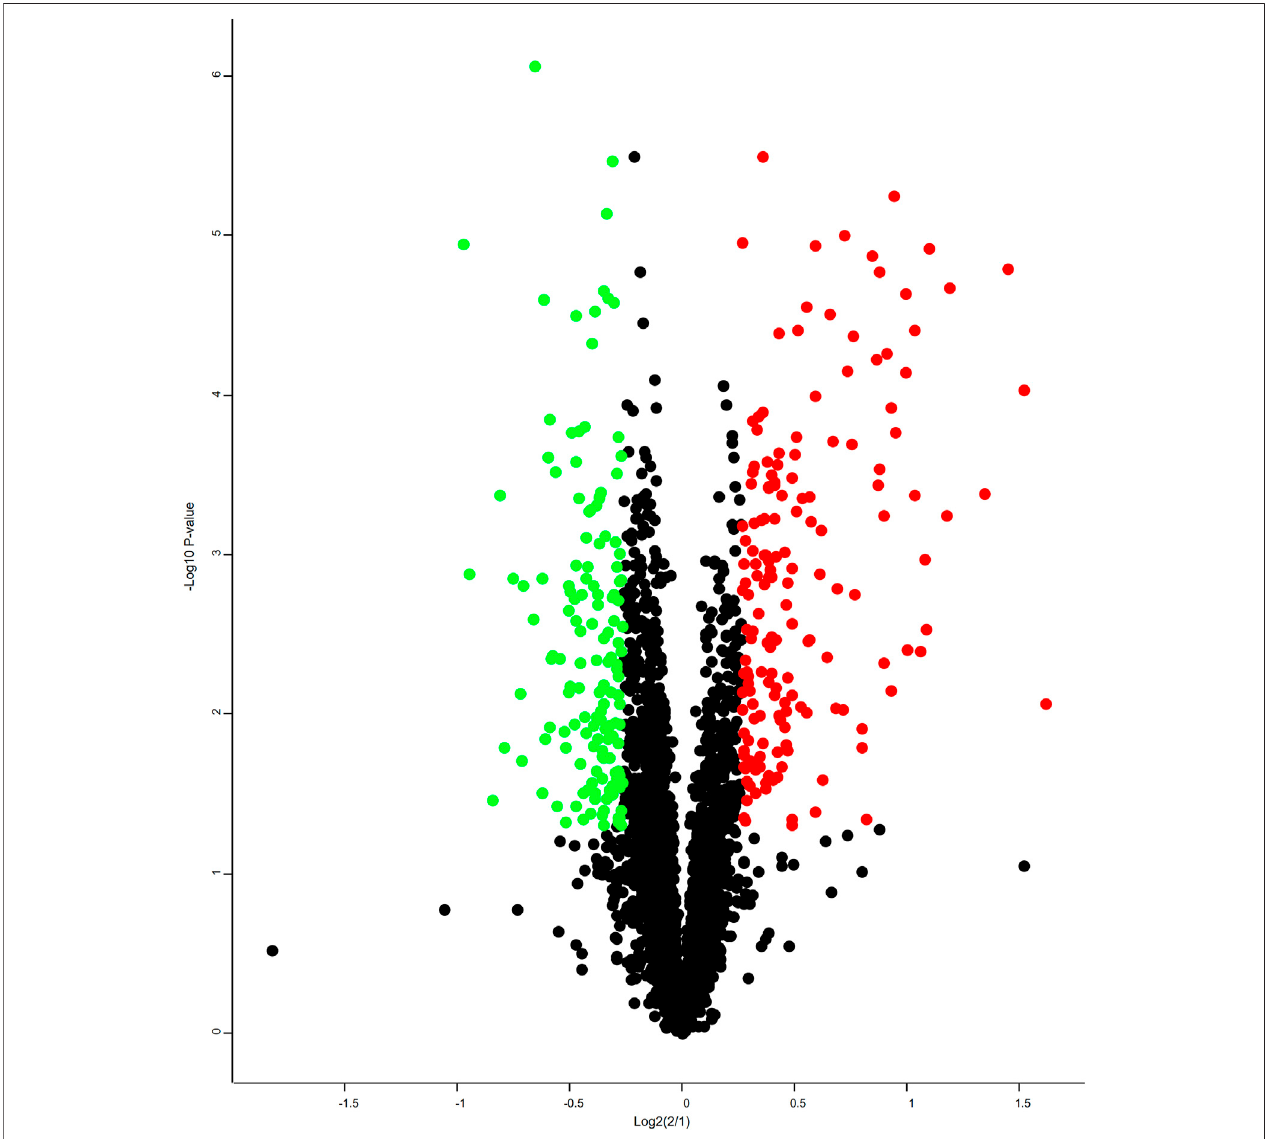
FIGURE 7 | Volcano plots. Each point in the differentially expressed volcanic map represents a protein, the abscissa is the log2 logarithm of the protein ratio between the two groups, and the ordinate is the – log10 logarithm of the p -value between the two groups. The greater the abscissa absolute value, the greater the difference in protein expression between the two groups of samples; the greater the vertical coordinate value, the more signi fi cant the differential expression, and the more reliable the screened DEPs. The green dots represent downregulated DEPs, the red dots represent upregulated DEPs, and the gray dots represent non- differentially expressed